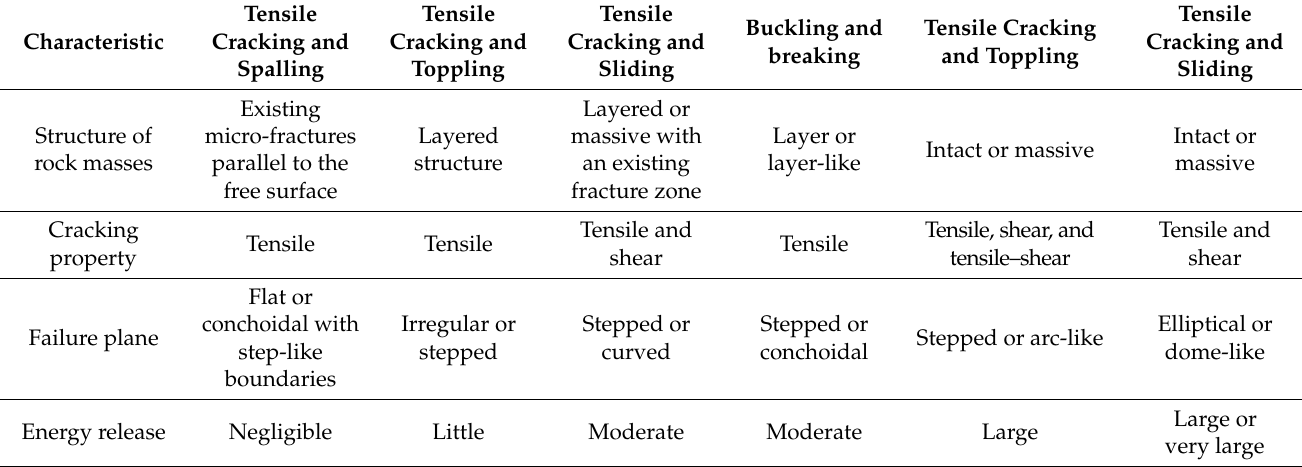
Table 3. Rockbursts and their properties [58].